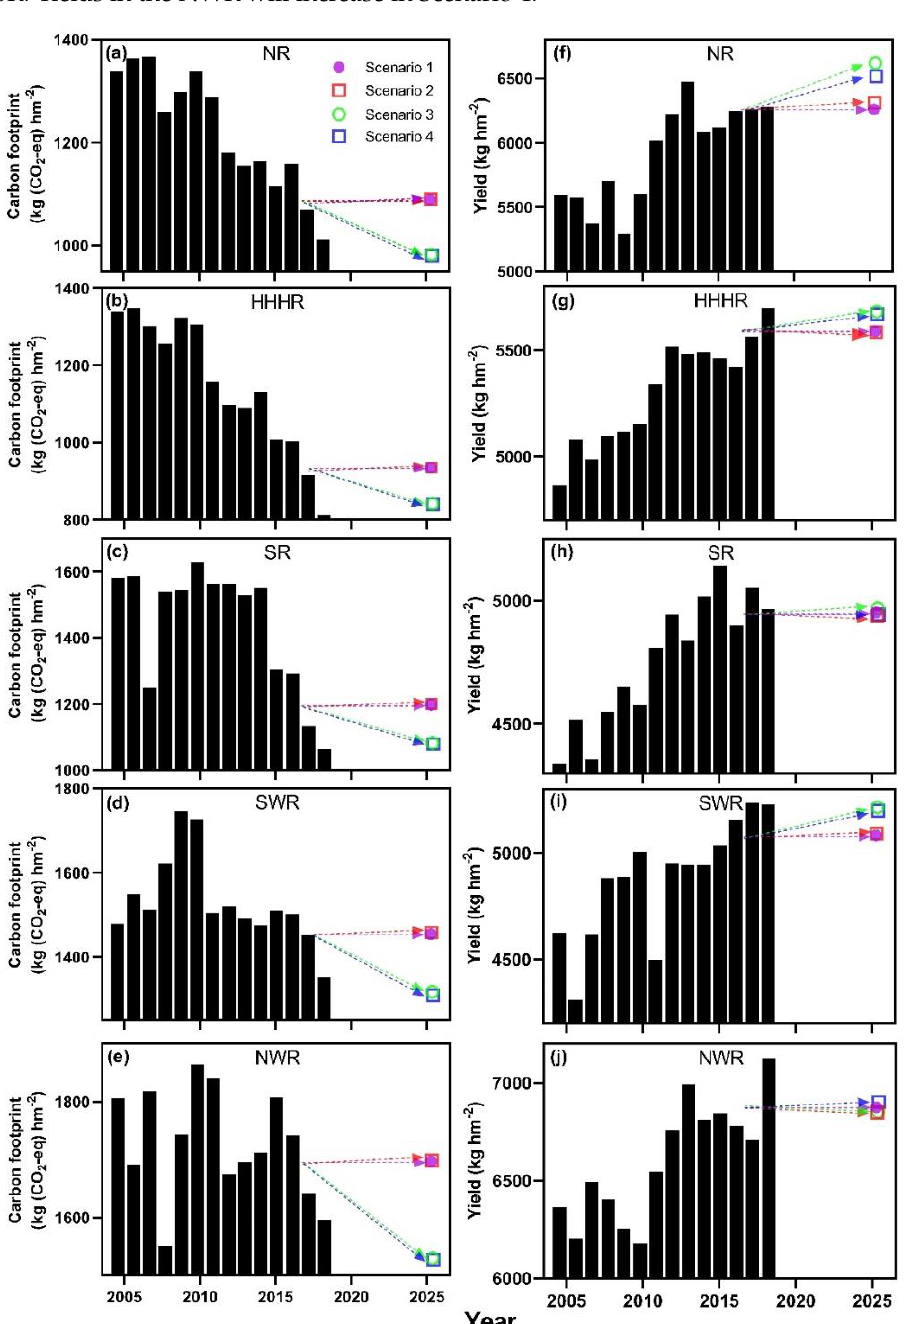
Figure 14. The per carbon footprints ( a – e ) and unit area yields ( f – j ) of each maize − growing region in China from 2005 to 2018, and the projections of the scenario analyses. NR: Northern region; HHHR: Huang − Huai − Hai region; SR: Southern region; SWR: Southwest region; NWR: Northwest region. Scenario 1: No change in N, P, and K fertilization rates. Scenario 2: No change in N application rates and 10% increase in P and K application rates. Scenario 3: A 10% decrease in N application rates and 10% increase in P and K application rates. Scenario 4: A 10% decrease in N, P, and K application rates.